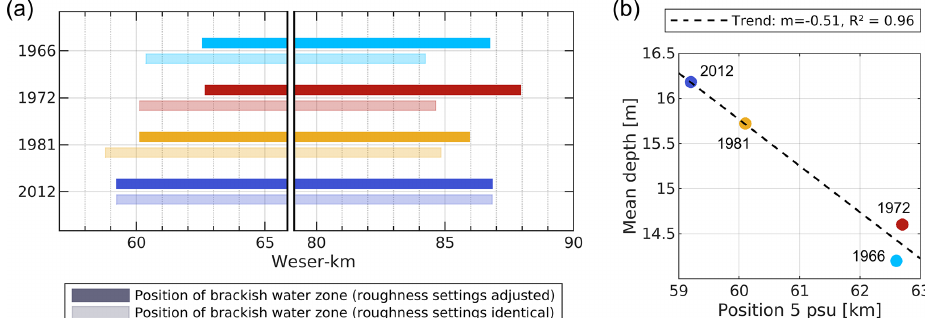
Figure 7. The left diagram (a) shows the effect of topography and roughness variation on the mean position of the brackish water zone (the stretch between the 5 psu and 20 psu isohalines along the navigation channel, see Fig. 1). The dark colours represent simulations with adjusted roughness settings; the light colours represent simulations with identical roughness settings. Forcing is identical. On the right (b) , the mean position of the 5psu isohalines in the simulations with adjusted roughness settings is displayed in relation to the mean depth of the navigation channel between Weser-km 40 to 100.